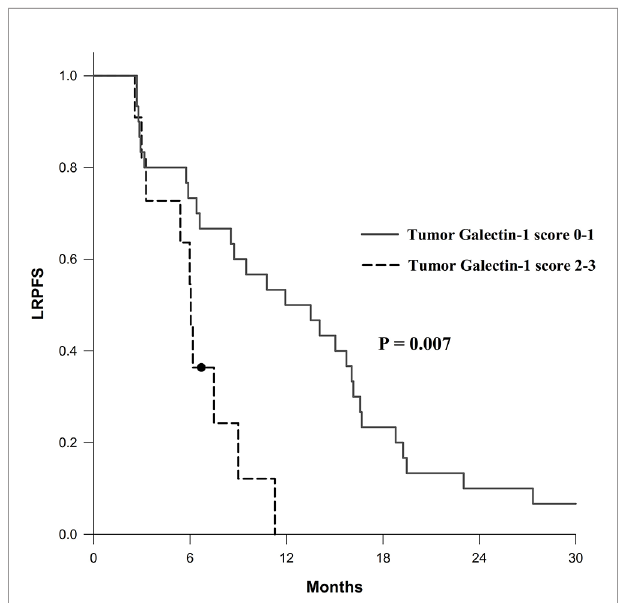
FIGURE 4 | Survival curve of locoregional progression-free survival (LRPFS) according to overexpression (score 2 – 3) versus non-overexpression (score 0 – 1) of tumor galectin-1. The p -value was calculated using log-rank test.